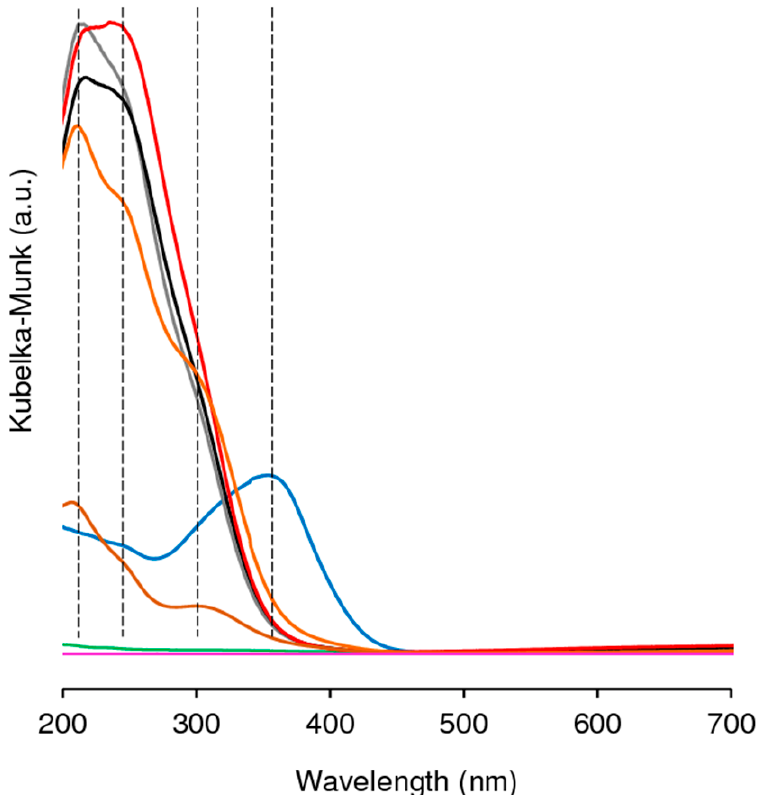
Figure 6. DR UV-vis spectra of TUD-1(PT) (green, close to baseline), Mo-TUD(IWI-acac) (black), Mo-TUD(IWI-ahm) (red), Mo-TUD(IWI-amm) (grey), Mo-TUD(HT) (orange), hierBEA (pink, close to baseline), Mo-hierBEA (brown), and for comparison, bulk MoO 3 (blue). Dashed lines signalize the bands at ca. 215, 250 and 300 nm, and 354 nm.